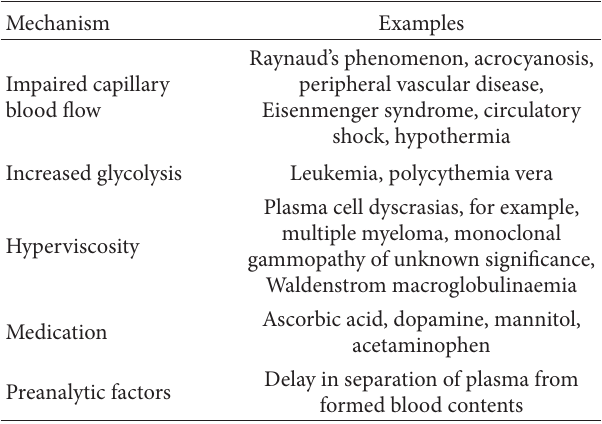
Table 1: Causes of pseudohypoglycaemia or artifactual hypogly-